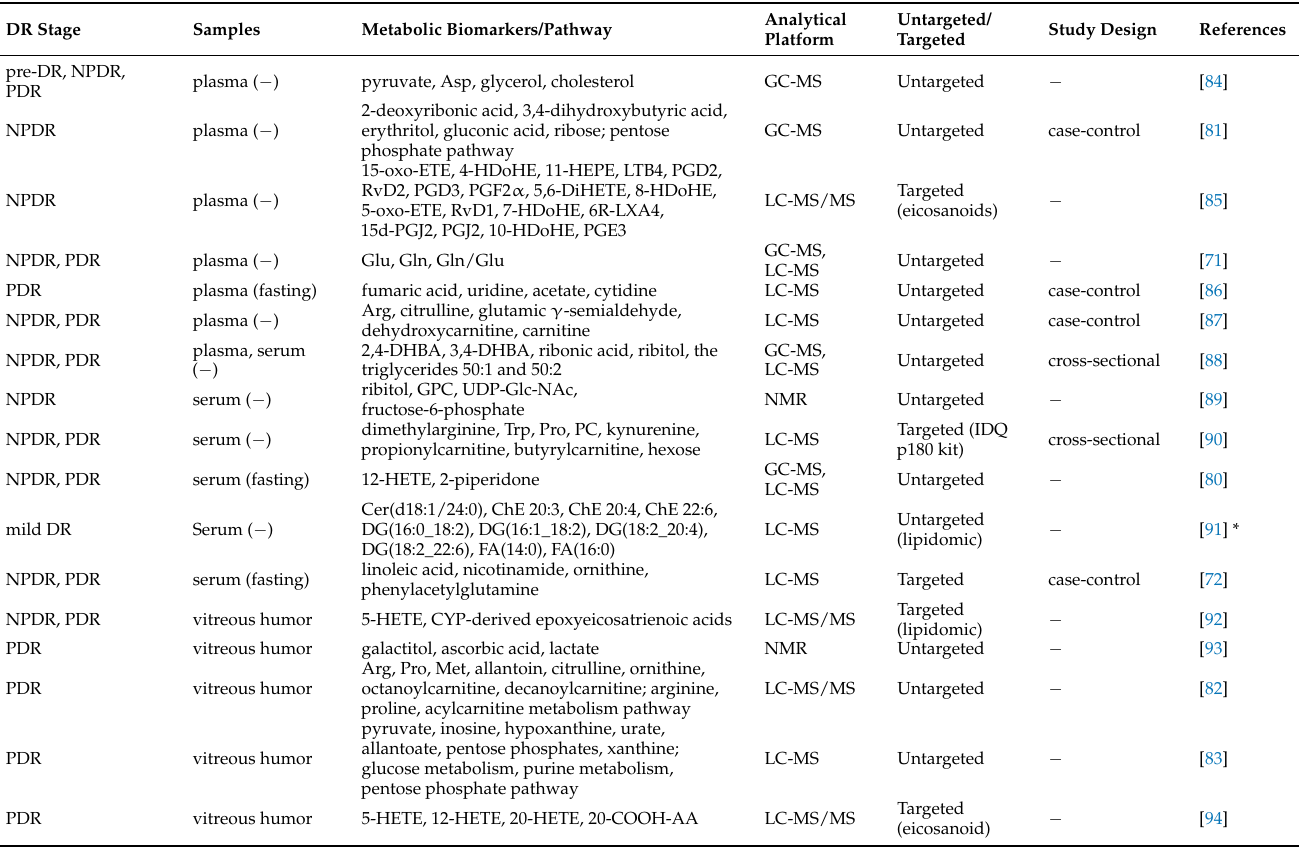
Table 2. Summary of metabolomics-based clinical studies of